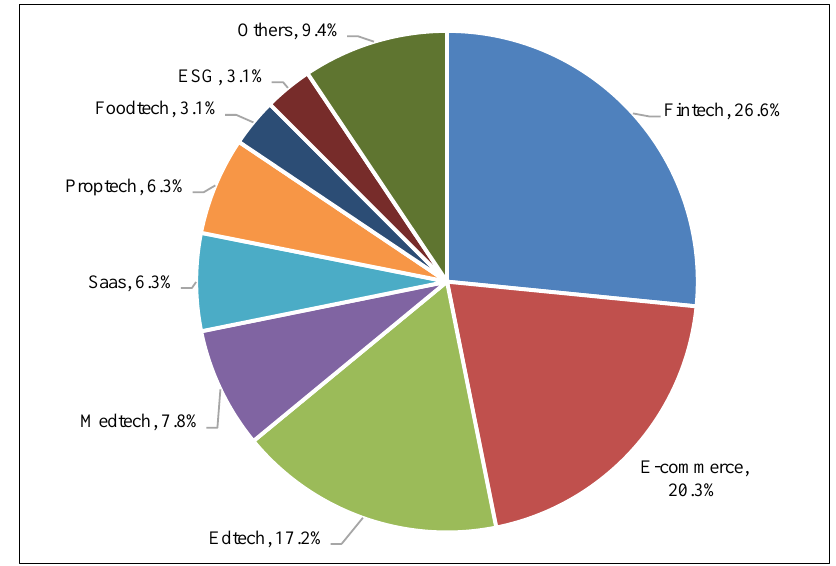
Figure 3. Investment for Vietnamese startups by sector in 2021 (Nextrans